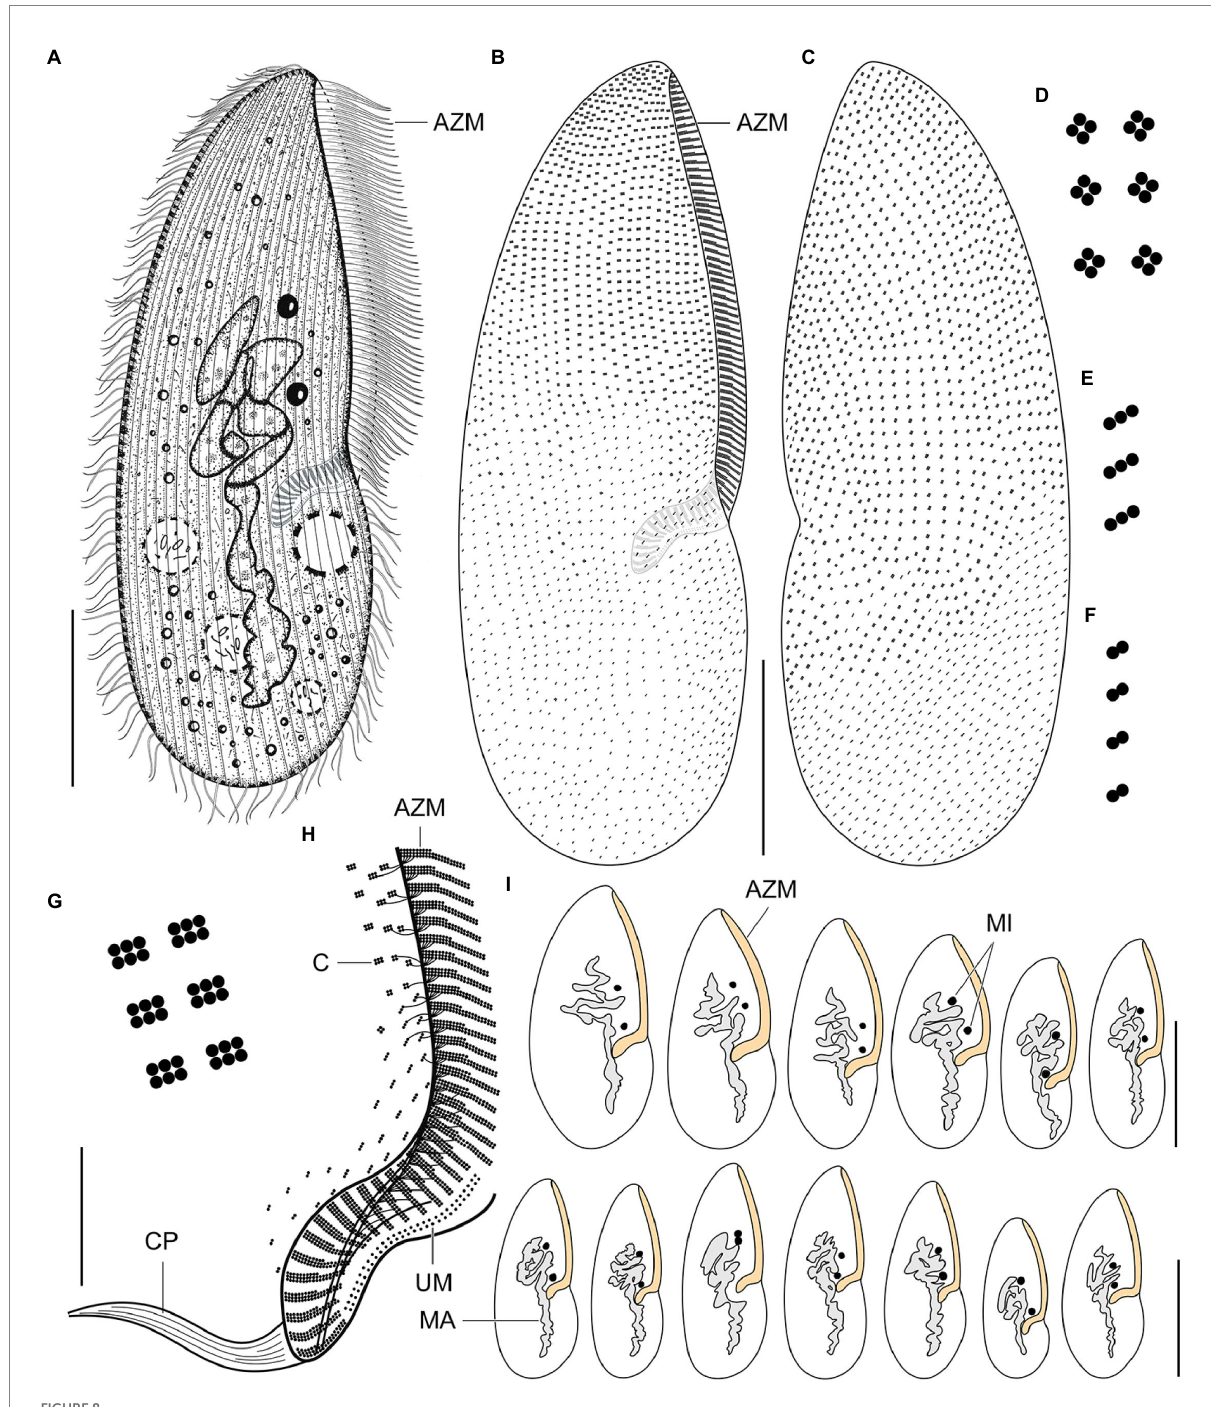
FIGURE 8 Plagiotoma aporrectodeae sp. n., type population from life (A) and after protargol impregnation (B–I) . (A) Ventral view of a representative specimen. The body is almost elliptical to narrowly elliptical, with a more or less pointed anterior end and a broadly rounded posterior end. The nuclear apparatus consists of 14–23 macronuclear nodules and invariably two micronuclei. The single contractile vacuole is localized posterior to the buccal vertex. (B, C) Cirral pattern of ventral and dorsal sides. Somatic ciliature is “holotrichous”-like, as cirri are indistinct and unspecialized. There are 18–25 ventral and 20–26 dorsal longitudinal cirral rows. (D–G) Fine structure of cirri in the anterior body region (G) , mid-body (D) , and posterior body region (E, F) . (H) Detail showing the oral ciliature. Adoral zone occupies about 51–67% of body length and consists of 65–77 membranelles, forming a Gonostomum -like pattern. (I) Variability of body shape and size as well as of the nuclear (shaded gray) and oral (shaded yellow) apparatus. AZM, adoral zone of membranelles; C, cirrus; CP, cytopharynx; MA, macronucleus; MI, micronuclei; UM, undulating membranes. Scale bars = 10 μ m (H) , 50 μ m (A–C) , and 100 μ m